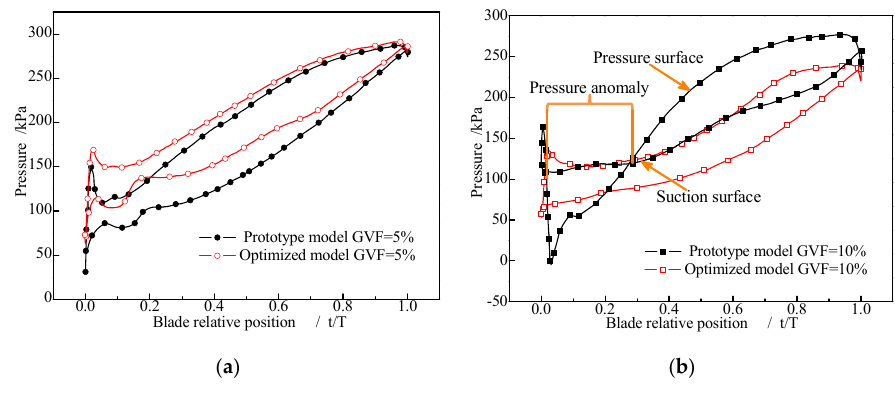
Figure 9. Impeller blade load distribution. ( a ) GVF = 5%; ( b ) GVF = 10%.